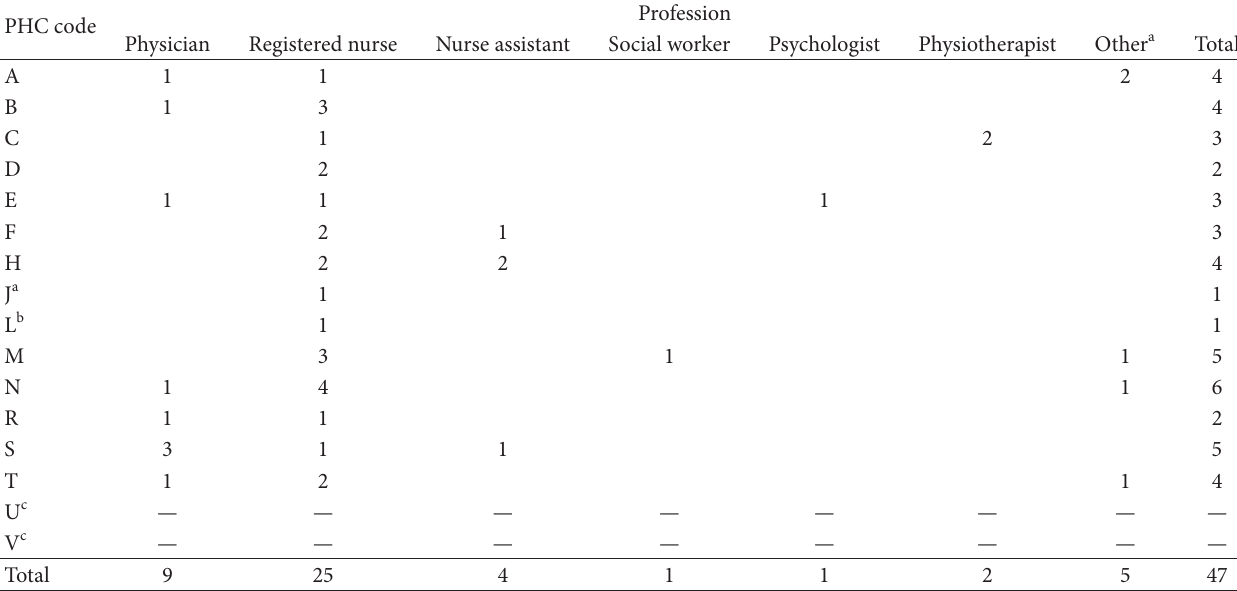
Table 2: Participants in the focus group interviews at follow-up in the SPIRA